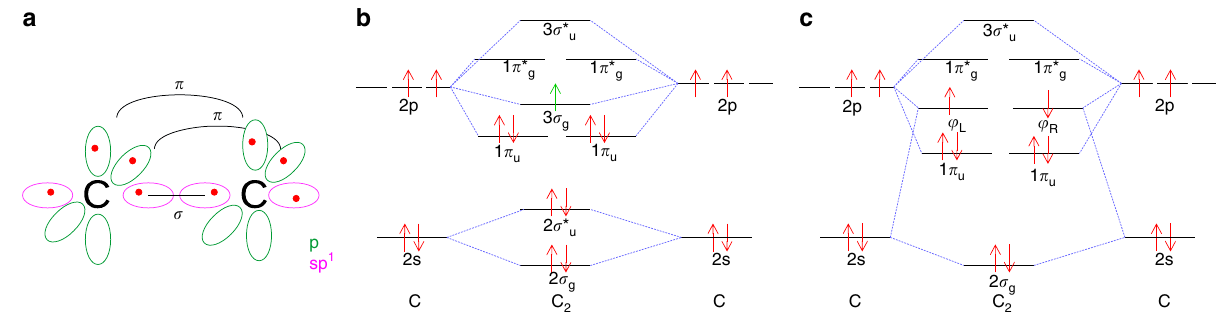
Fig. 1 Orbital descriptions of C 2 using different approaches, highlighting the uncertain bond nature of dicarbon. a Hybrid-orbital picture of C 2 , involving sp 1 hybridisation on the carbon atoms. This approach suggests a triple-bonded dicarbon molecule, with one σ and 2 π bonds, as represented by solid black lines. b Molecular orbital diagram for C 2 , predicting a double bond between the C atoms consisting of 2 π bonds, without an accompanying σ bond. The additional electron for the anion C (cid:1) is shown in green. c Orbital diagram for C 2 from a valence-bond viewpoint. Due to the quasi-degenerate nature of orbitals 2 ; 3 σ 2 σ and 1 π , the 2 σ (cid:3) and 3 σ orbitals mix to form sp 1 -like hybrid orbitals on each of the carbons. Valence bond theory suggests a fourth bond u g u g u